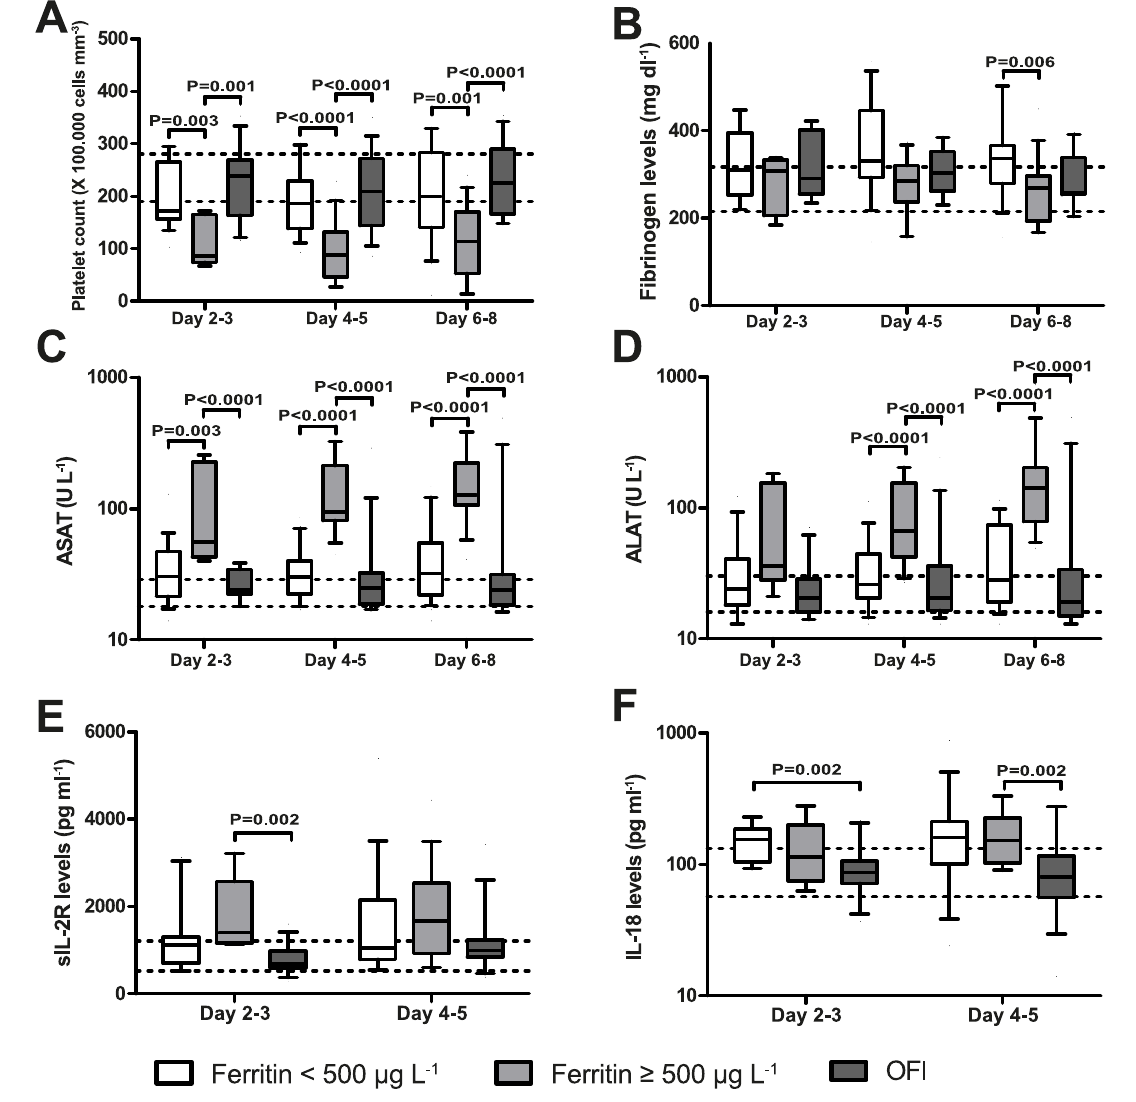
Figure 3. Hyperferritinaemia is associated with certain markers of HLH and MAS. The platelet count (A) was significantly decreased and the liver enzyme ASAT (C) significantly increased in patients with hyperferritinaemia compared to patients with no hyperferritinaemia and OFI at each time point in the cohort from Aruba. Levels of fibrinogen were significantly decreased in patients with hyperferritinaemia compared to patients without hyperferritinaemia at day 6–8 (B). Levels of ALAT were significantly increased in patients with hyperferritinaemia at day 4–5 and 6–8 (D). Levels of sIL-2R were significantly increased in patients with hyperferritinaemia compared to OFI at day 2–3 (E). Levels of IL-18 were significantly increased in patients with no hyperferritinaemia compared to OFI at day 2–3 and in patients with hyperferritinaemia compared to OFI at day 4–5 (F). Missing values: Platelet count, ASAT, ALAT: no missing values. sIL-2R and IL-18: Day 2–3: No HF (N=3), HF (N=2). Day 4–5: No HF (N=5), HF (N=3). Area between two dotted horizontal lines: interquartile range from the autologous control group. Boxplots indicate the interquartile range, the horizontal line inside the box indicates the median. The whiskers reach from the 10 th till the 90 th percentile. P-value # 0.006 is considered significant.